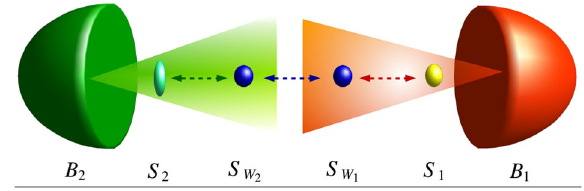
Fig. 3 Extraction of free entropy. A battery S W sub-systems S